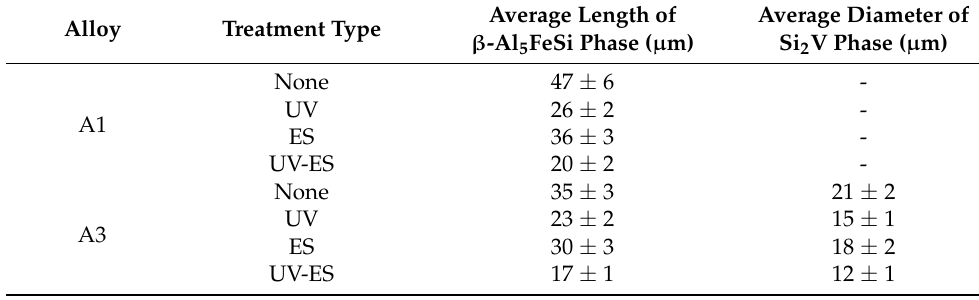
Table 4. Average size of β -Al 5 FeSi and Si 2 V phases of the alloys treated by different physical fields.